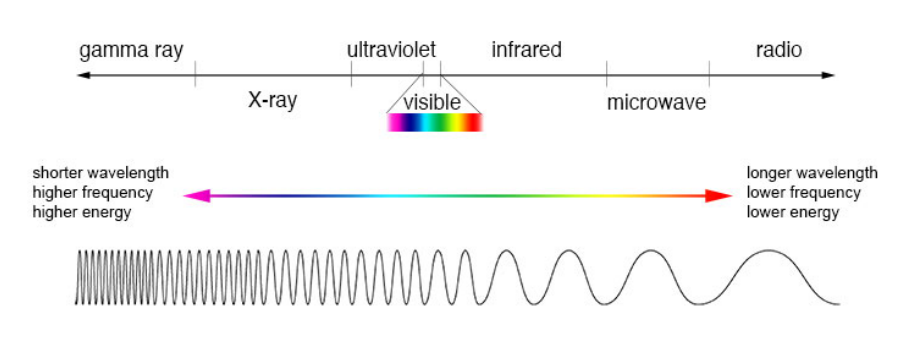
Figure 1. Comparison of wavelength, frequency and energy in the electromagnetic spectrum [40] (credit: